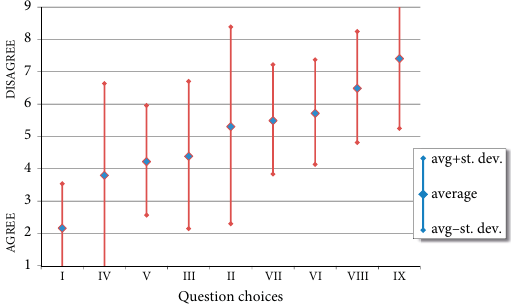
Fig. 1. Marketing perspectives of construction companies